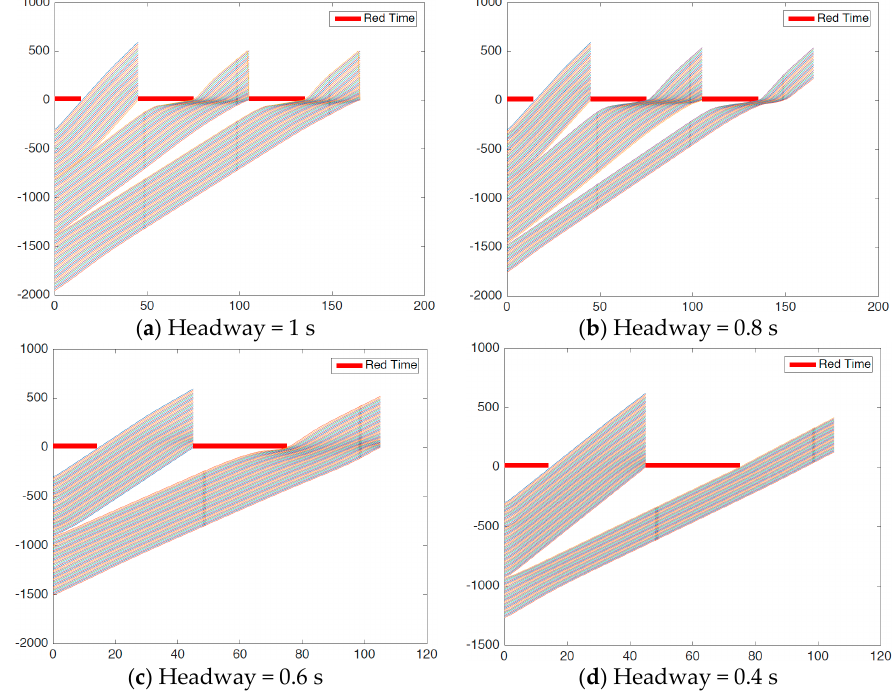
Figure 3. Optimal CAV trajectories for the proposed control algorithm under di ff erent initial following